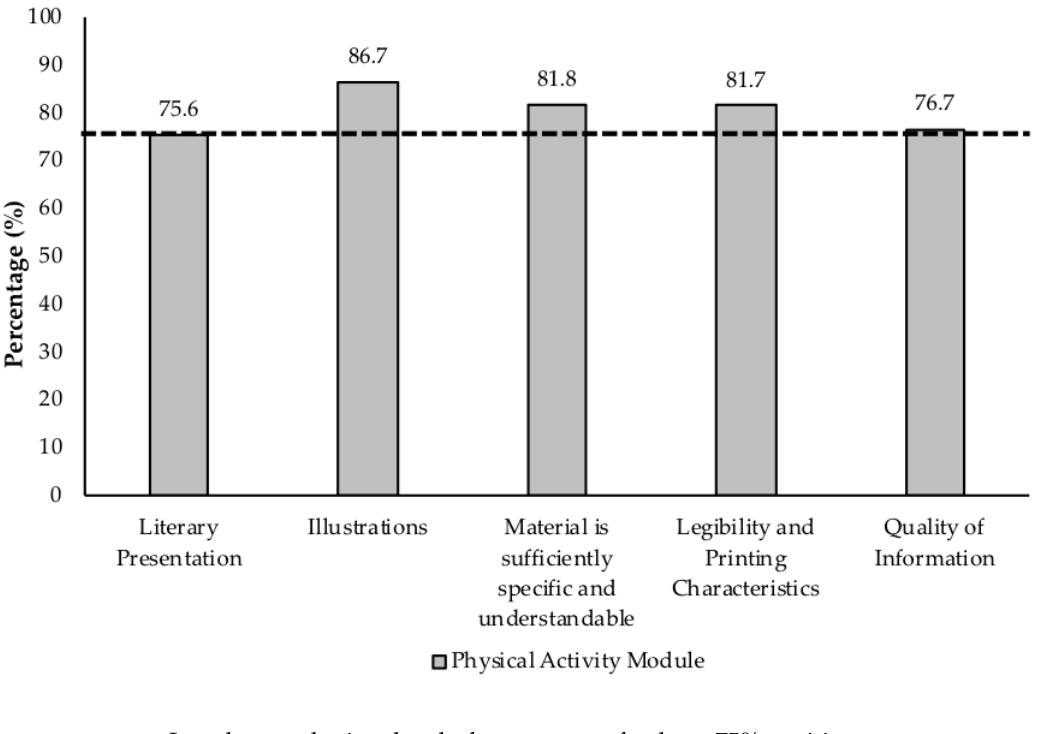
Figure 1. Level of agreement among experts for evaluative aspects of face validity.